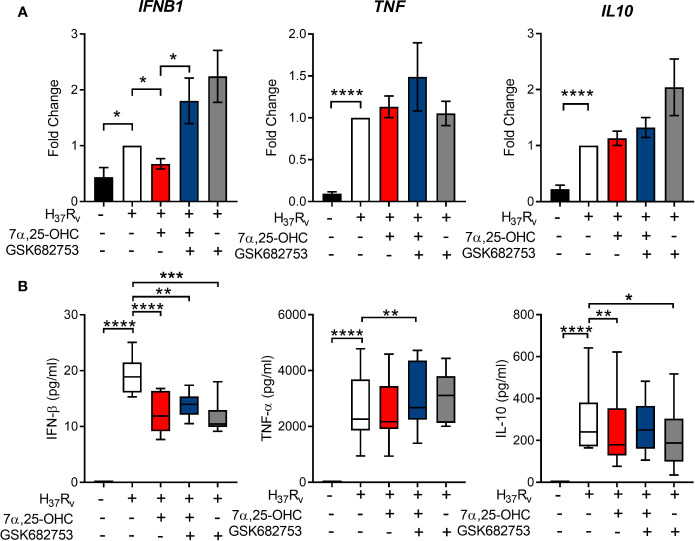
Activation of GPR183 leads to cytokine production favoring Mtb control. Primary MN from healthy donors (n = 8) were infected for 2 h with Mtb H37Rv (MOI 10:1), 7a,25-OHC (100 nM), and/or GSK682753 (10 μM). Cells were washed and left with drugs for a further 22 h. Changes in the expression of (A) IFNB1, TNF, and IL10 were measured by qPCR and normalized to untreated infected cells. Concentrations of (B) IFN-b, TNF-a, and IL-10 in the culture supernatant were measured by ELISA. Data are presented as mean fold change ± SEM or min to max for box plots; *P ≤ 0.05; **P ≤ 0.01; ***P ≤ 0.001; ****P ≤ 0.0001; paired t-test.